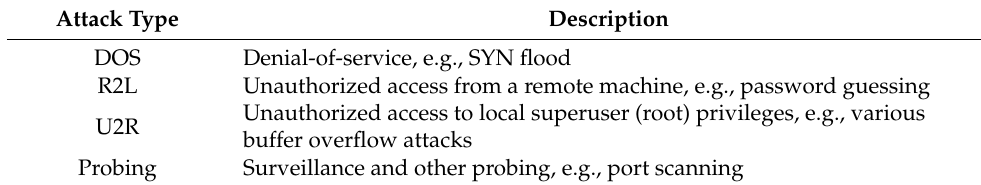
Table 1. The attack type of KDDcup99 data